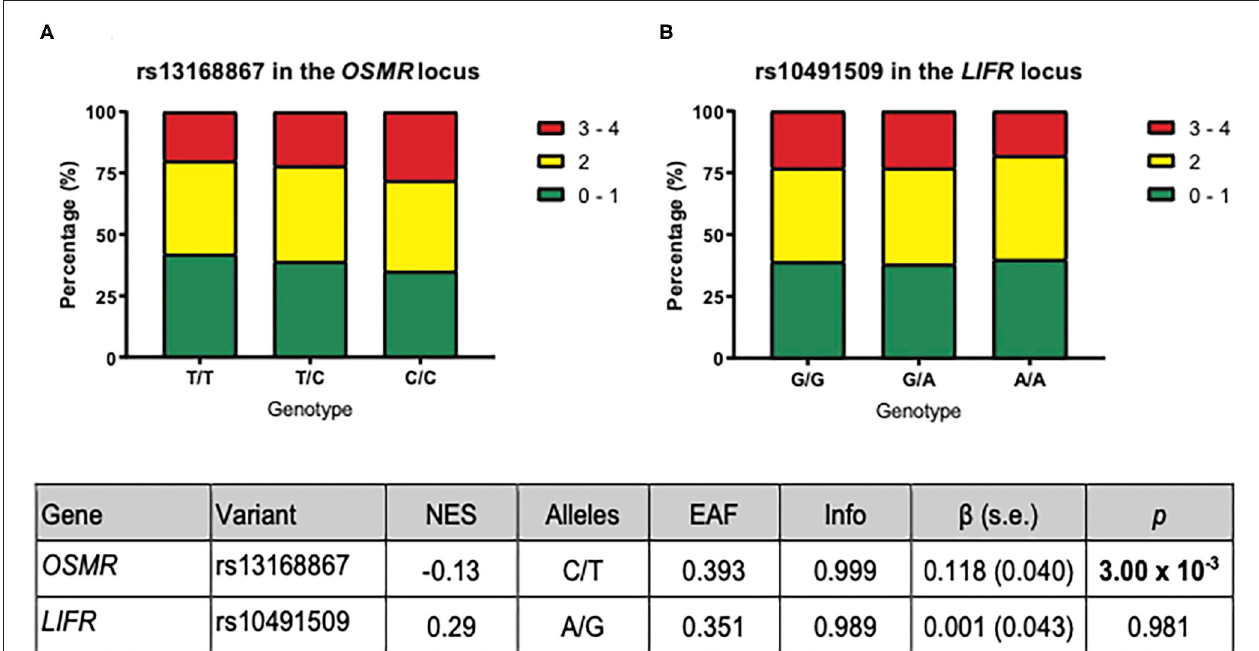
FIGURE 2 | Association of OSMR and LIFR variants with overall plaque vulnerability. The plaques were given a vulnerability score ranging from 0 (least vulnerable) to 4 (most vulnerable). The bars represent the proportion of each plaque score per genotype for rs13168867 in the OSMR locus (A) and rs10491509 in the LIFR locus (B) . The table shows the results from GTEx Portal ( 23) where Gene is the gene of interest; Variant is the eQTL as found in GTEx Portal, and NES refers to the normalized effect size on expression from GTEx Portal. The Alleles refer to the effect allele and the other allele in both GTEx Portal and the Athero-Express Biobank. The remaining columns in the table are referring to the analysis of these eQTLs with respect to plaque vulnerability in the Athero-Express Biobank Study. Here EAF represents effect allele frequency; Info refers to the estimated imputation score. The effect size ( β ) and standard error (s.e.) are relative to the effect allele; p indicates the p -value of association with plaque vulnerability of the given eQTL; Bold p : p -value of association surpasses significance threshold ( p < 3.13 × 10 − 3 ).